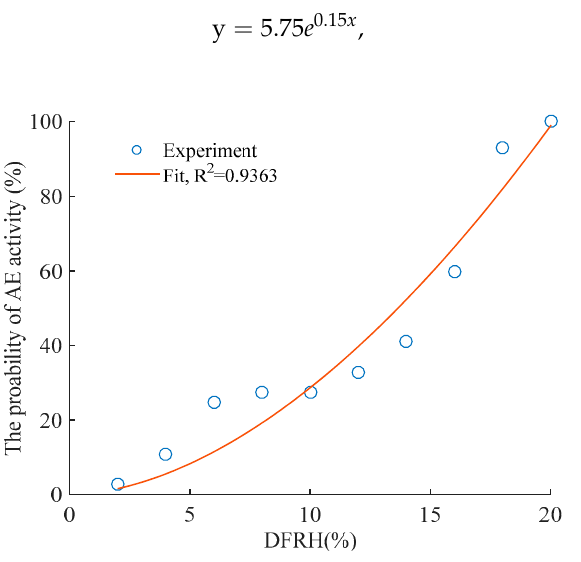
Figure 14. The probability of AE activity of the ancient wooden ship under a different range of DFRH.